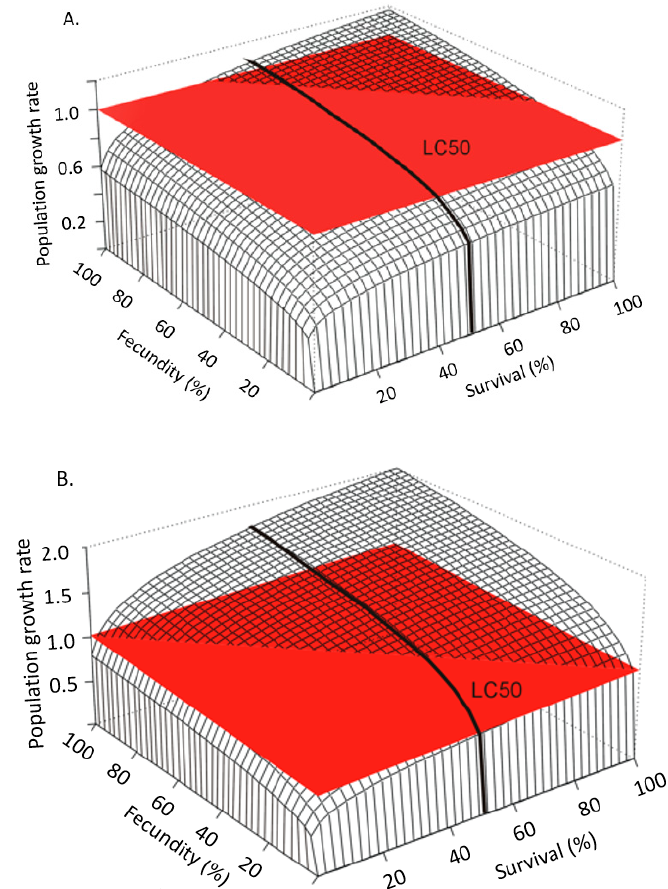
Figure 3. Demonstration of risk (i.e., λ < 1) as a function of life history and variability of risk tolerance around a point estimate (LC 50 ) for ( A ) mysid shrimp and ( B ) gypsy moth with low and high population potential, respectively, as defined by the value of population growth rate (from Raimondo et al. [33], reprinted with permission).